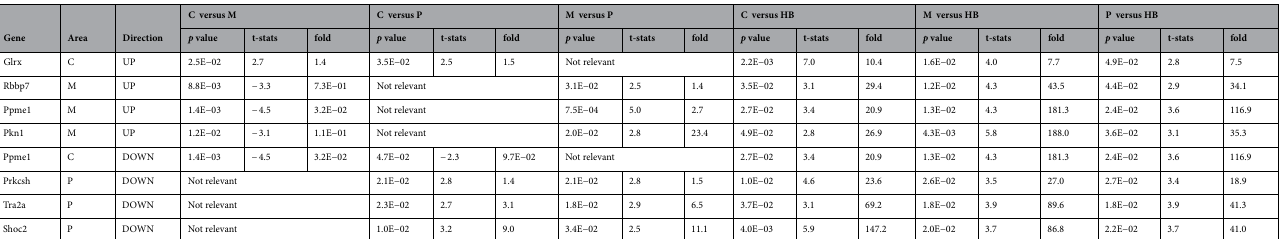
Table 2. Potential 4T1 tumor biomarkers that significantly differ (“Methods” section) between three tumor areas. C—Center; M—Middle; P—Periphery; HB—Healthy